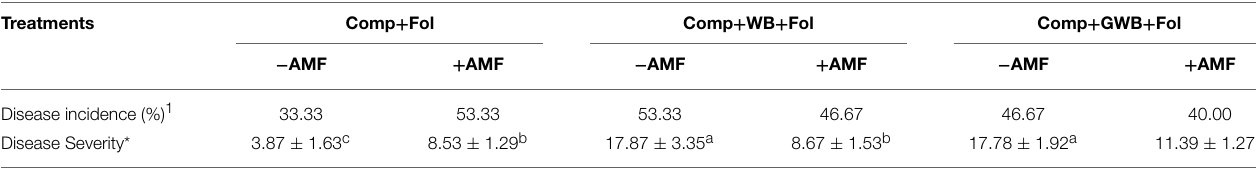
TABLE 4 | Effect of different soil substrates [compost (Comp), combination of compost with wood biochar (Comp + WB) and with green waste biochar (Comp + GWB) inoculated with Fol ( + Fol), with ( + AMF) or without AMF ( − AMF)] on the disease incidence and severity by F. oxysporum f.sp. lycopersici on tomato plants, 6 weeks after inoculation.